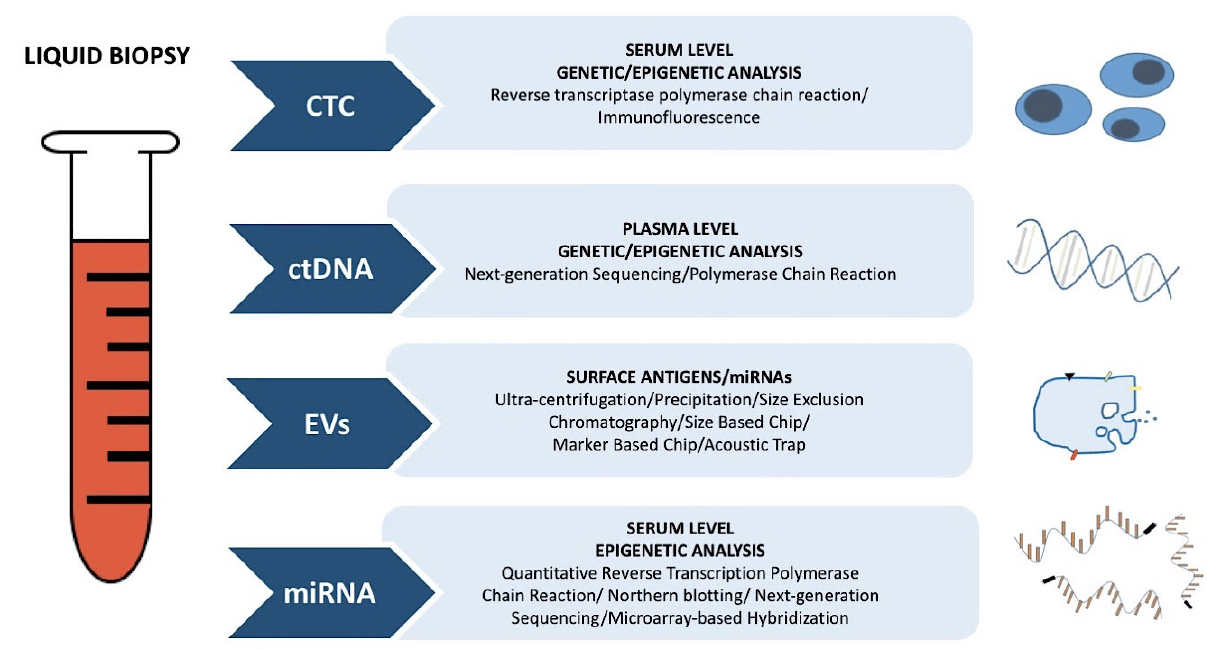
Figure 3. Liquid Biopsy: what is assessed and methods of detection.